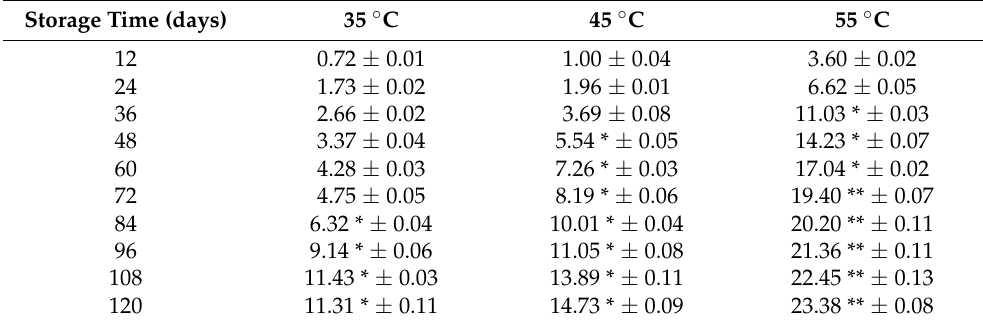
Table 4. Effect of temperature on the total color difference ( ∆ E ) of H. macrocarpa and nanocellu- lose